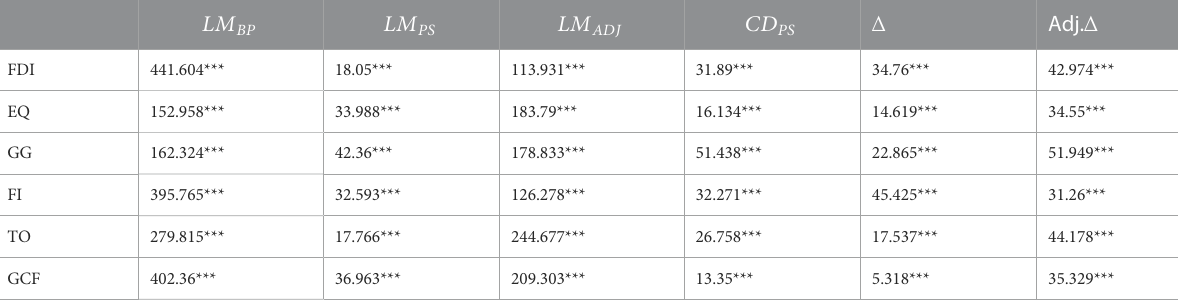
TABLE 2 Results of the cross-sectional dependency test and heterogeneity